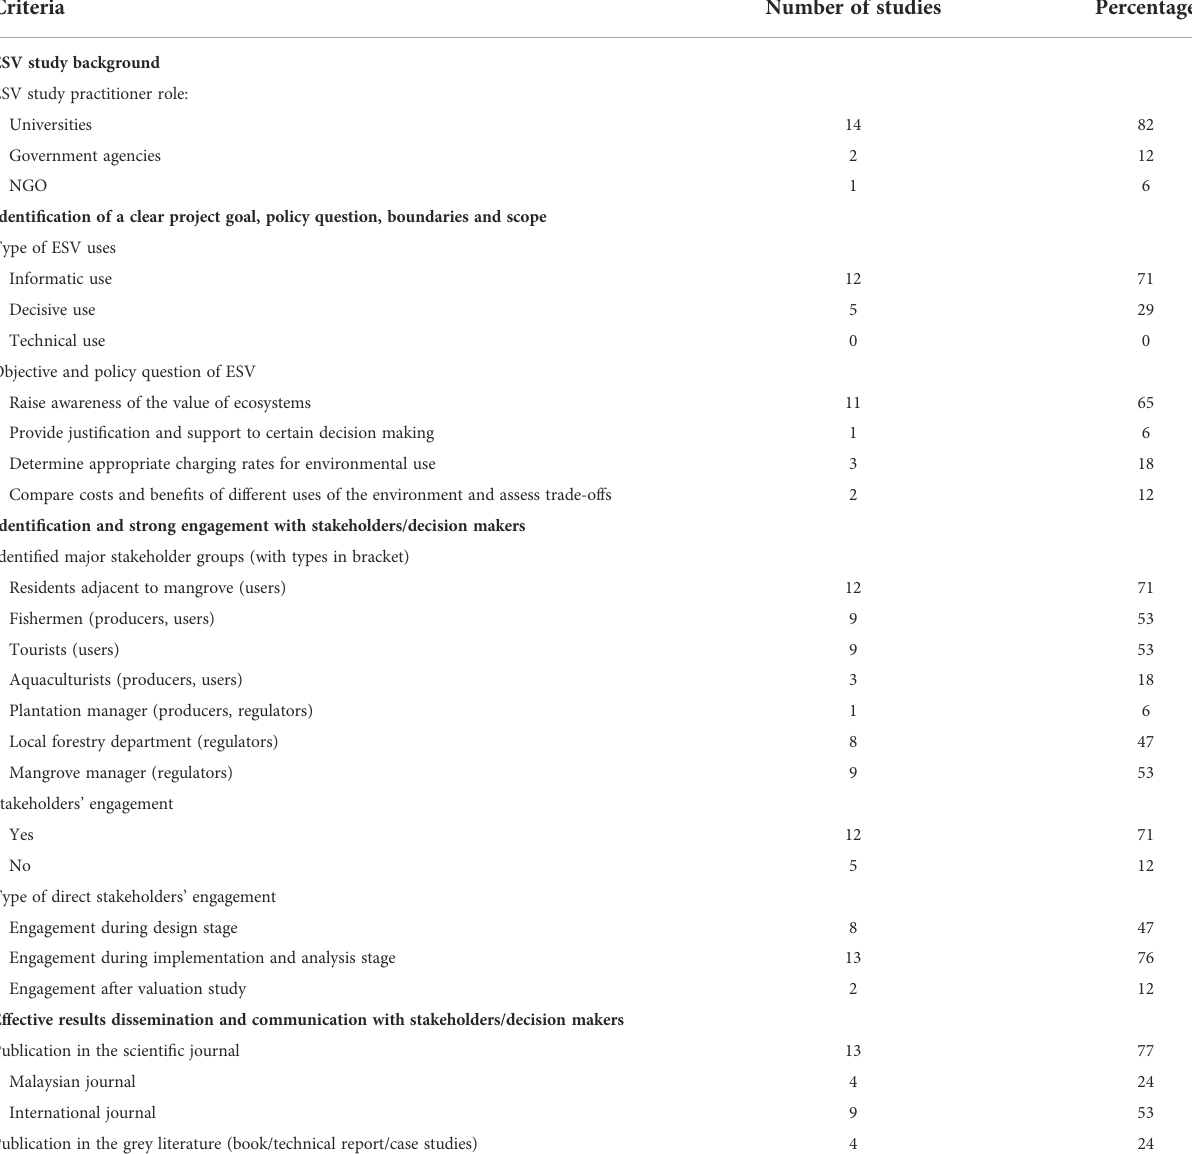
TABLE 4 Summary of Malaysia ecosystem service valuation (ESV) assessment based on best practices